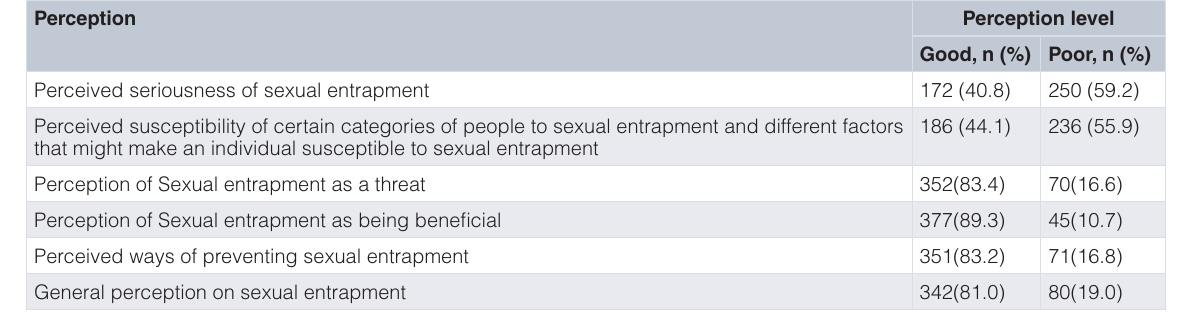
Table 3. Perception towards various aspects of sexual entrapment (N= 422).